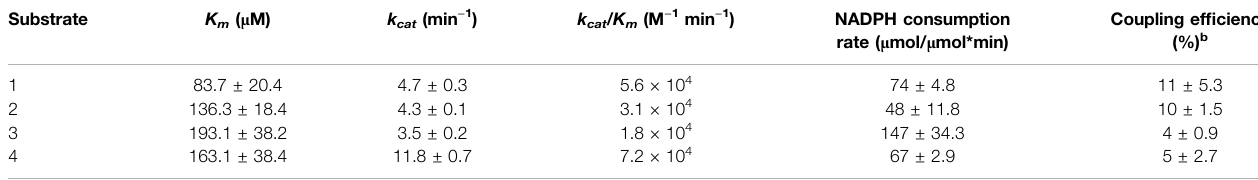
TABLE 1 | Kinetic parameters of CYP109B1 catalyzed steroids hydroxylation a .